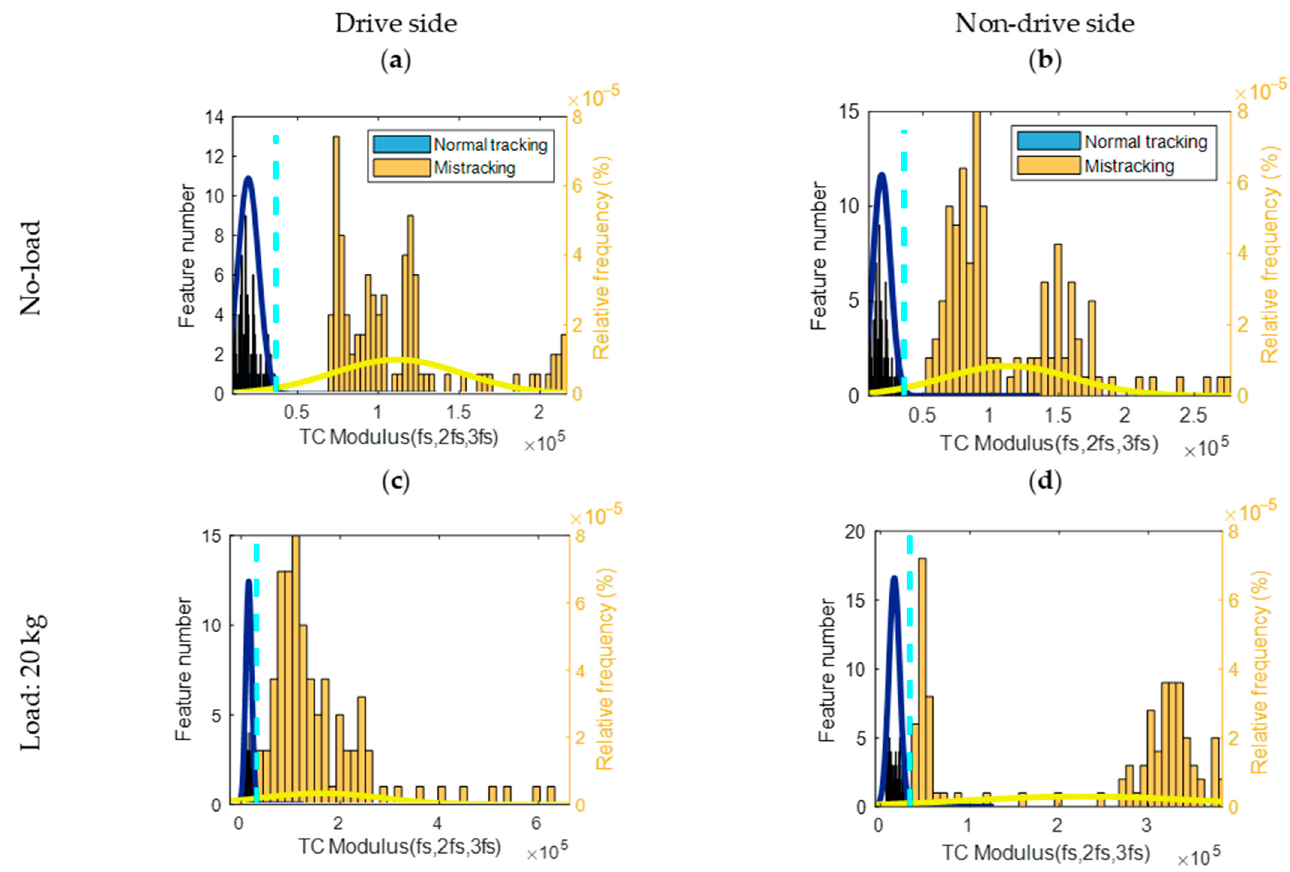
Figure 6. Histogram, normal power density function and diagnostic threshold represented as the aqua do tt ed line of the tricoherence (fs, 2fs, 3fs) for normal and mis-tracking conditions: ( a ) Drive side belt mis-tracking under no-load condition, ( b ) Non-drive side belt mis-tracking under no-load condition, ( c ) Drive side belt mis-tracking under 20 kg load condition, ( d ) Non-drive side belt mis- tracking under 20 kg load condition.